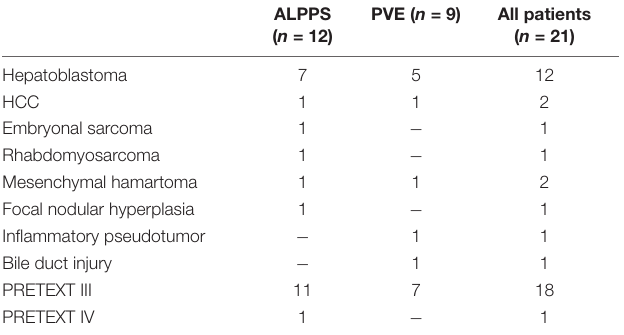
TABLE 5 | Details on the types of liver tumors or underlying disease.